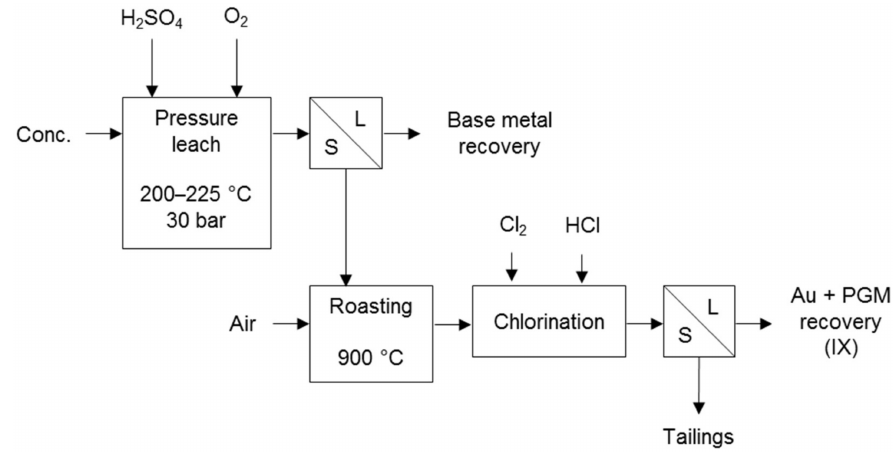
Figure 4. Block diagram of the Kell process (adapted from Liddell & Adams [10]).